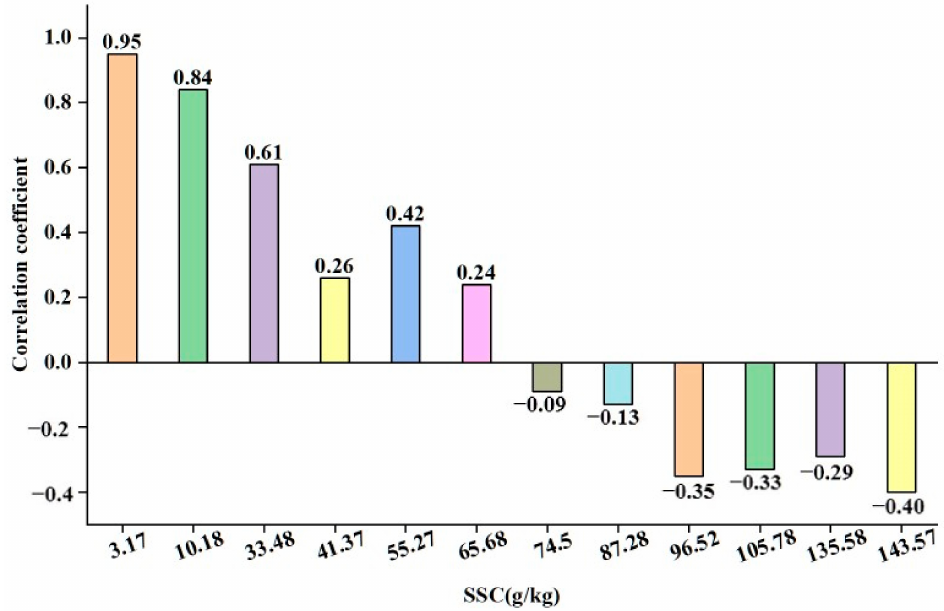
Figure 5. Correlation between ASD data and AHSI data under different SSCs.